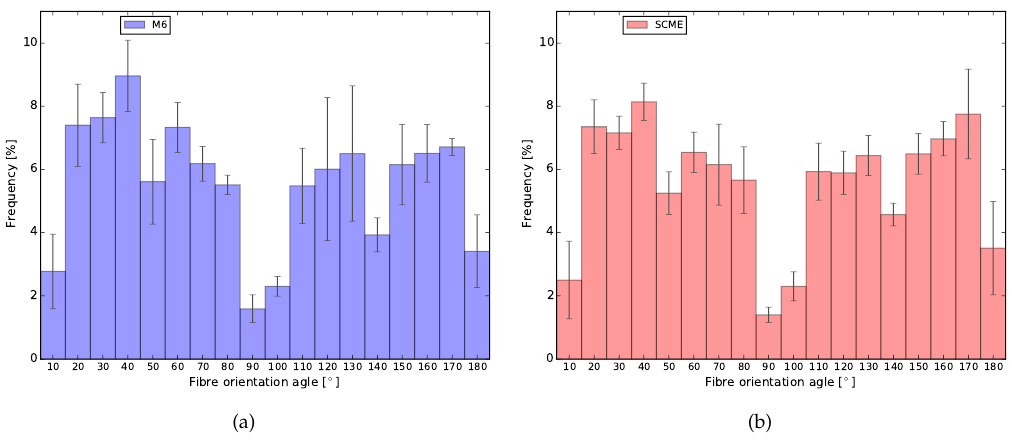
Figure 17. Average fibre orientation of both printed mixtures. ( a ) XVA3PVA20; ( b ) YVA4PVA20.